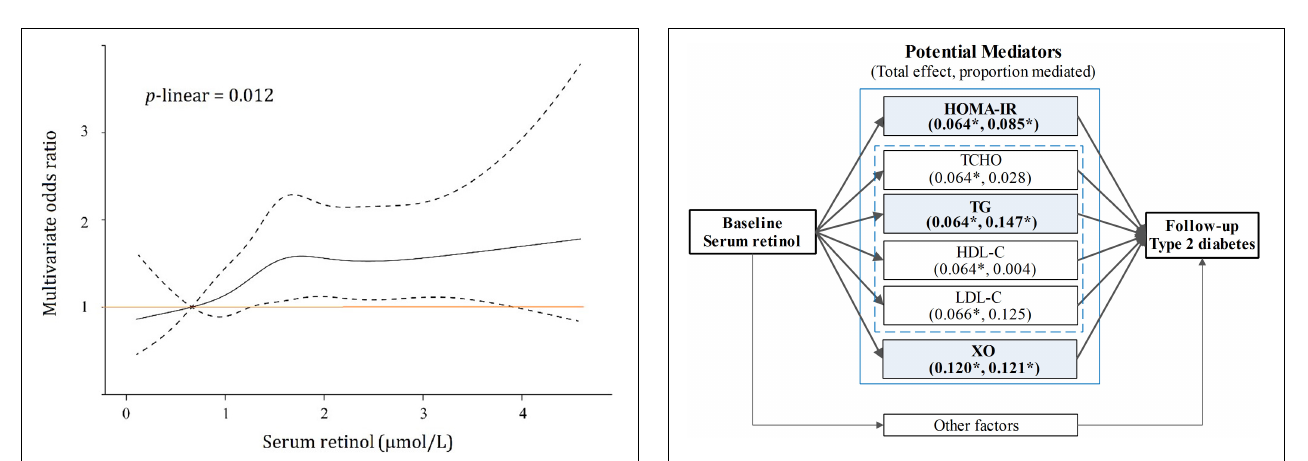
FIGURE 4 | The mediation analysis for the total effect of serum retinol on type 2 diabetes risk. HOMA-IR, the insulin resistance index, was calculated using the following equation: HOMA-IR = (FBG × F-insulin)/22.5; TG, triglyceride; TCHO, total cholesterol; HDL-C, high-density lipoprotein cholesterol; LDL-C, low-density lipoprotein cholesterol; XO, xanthine oxidase. The mediation analysis models were adjusted for age, gender, current smoker, current drinker, exercising regularly, education level, physical activity, dietary vitamin A intake, dietary energy intake, dietary lipid intake, BMI, hypertension, hyperlipidemia, coronary disease, and a family history of diabetes. * p <